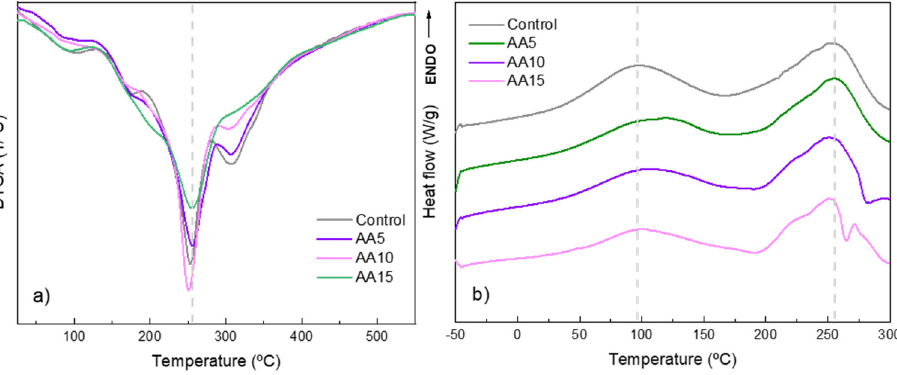
Figure 3. ( a ) TGA derivative (DTGA) and ( b ) DSC thermograms of WPI films as a function of ascorbic acid (AA) content.